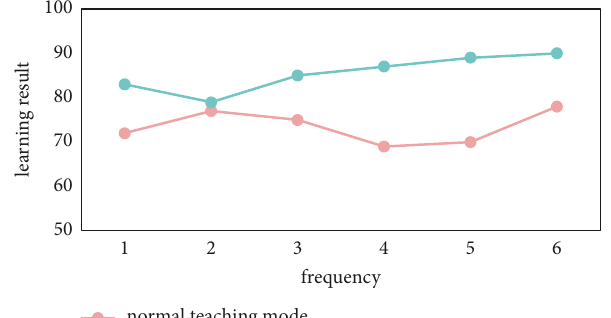
Figure 8: Comparison of different teaching modes in terms of learning